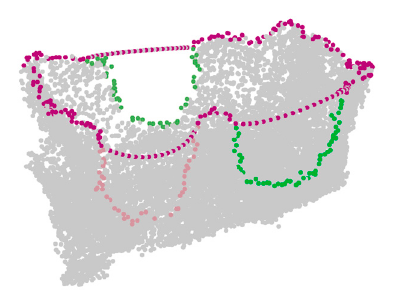
Figure 10. Example of the hole boundaries repair